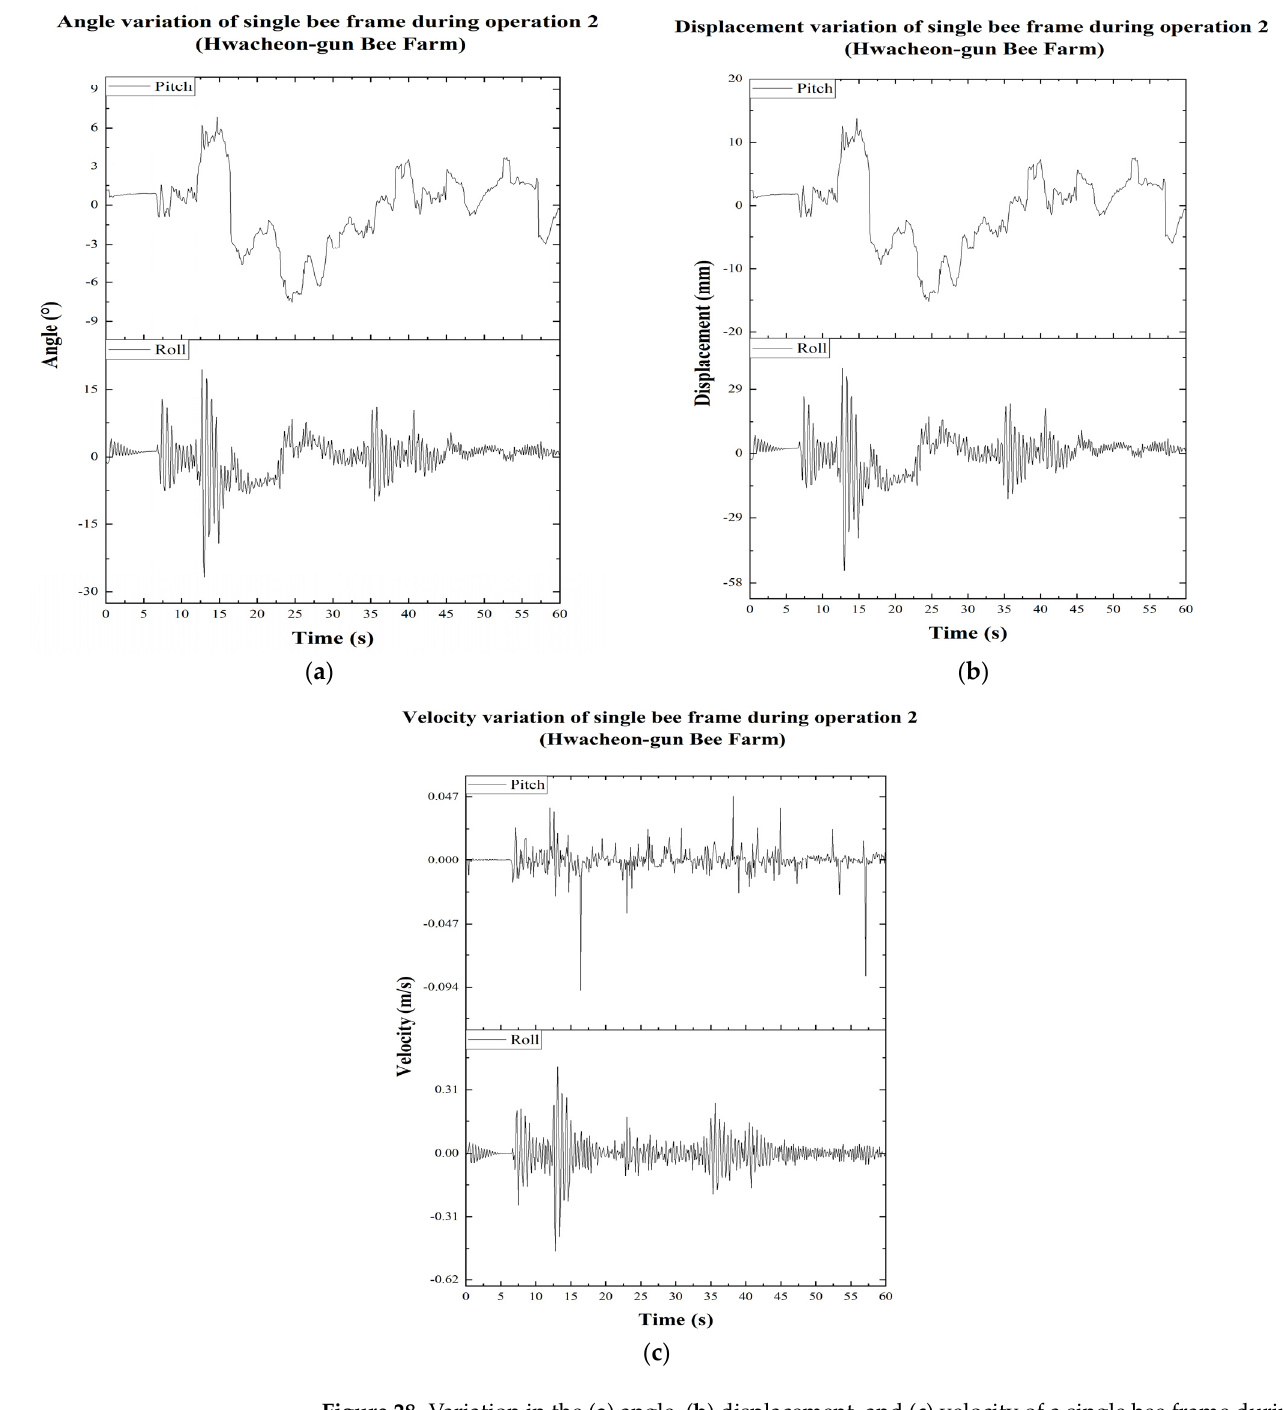
Figure 28. Variation in the ( a ) angle, ( b ) displacement, and ( c ) velocity of a single bee frame during actual transportation.